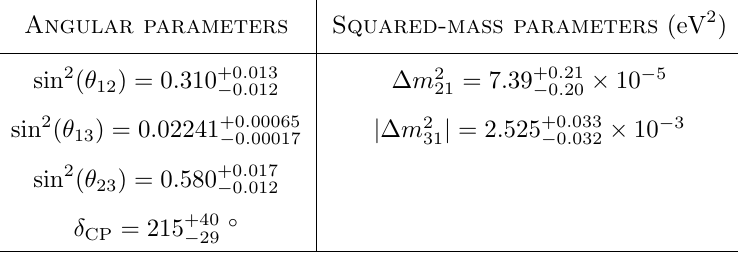
Table 1. Summary of the average neutrino oscillation parameters from the NuFIT collabora- tion [14], with the assumption of normal ordering. The angles, (cid:18) ij , can be taken without loss of generality to be within the (cid:12)rst quadrant. We implement these central values throughout this work. Majorana phases (cid:11) 1 ; 2 are entirely